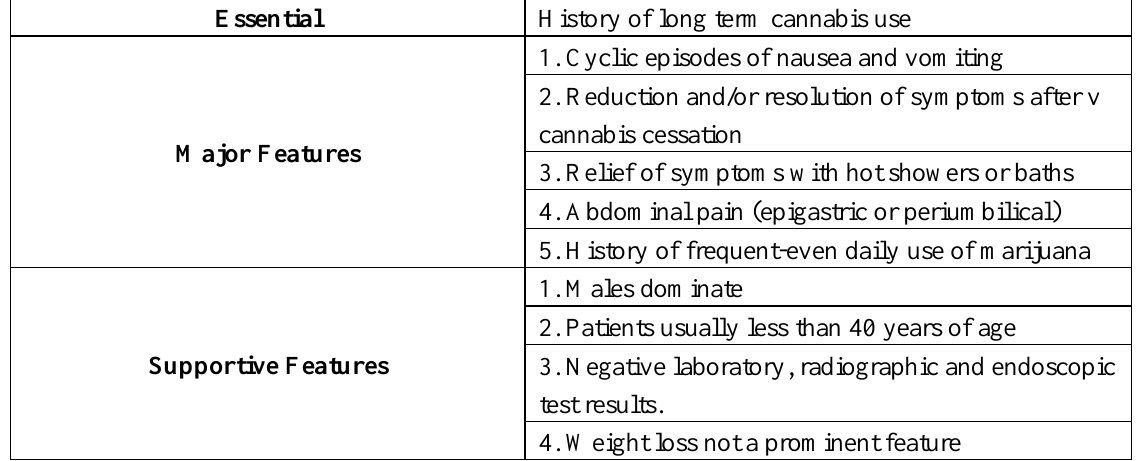
Table 2. Cannabinoid hyperemesis syndrome: Proposed criteria